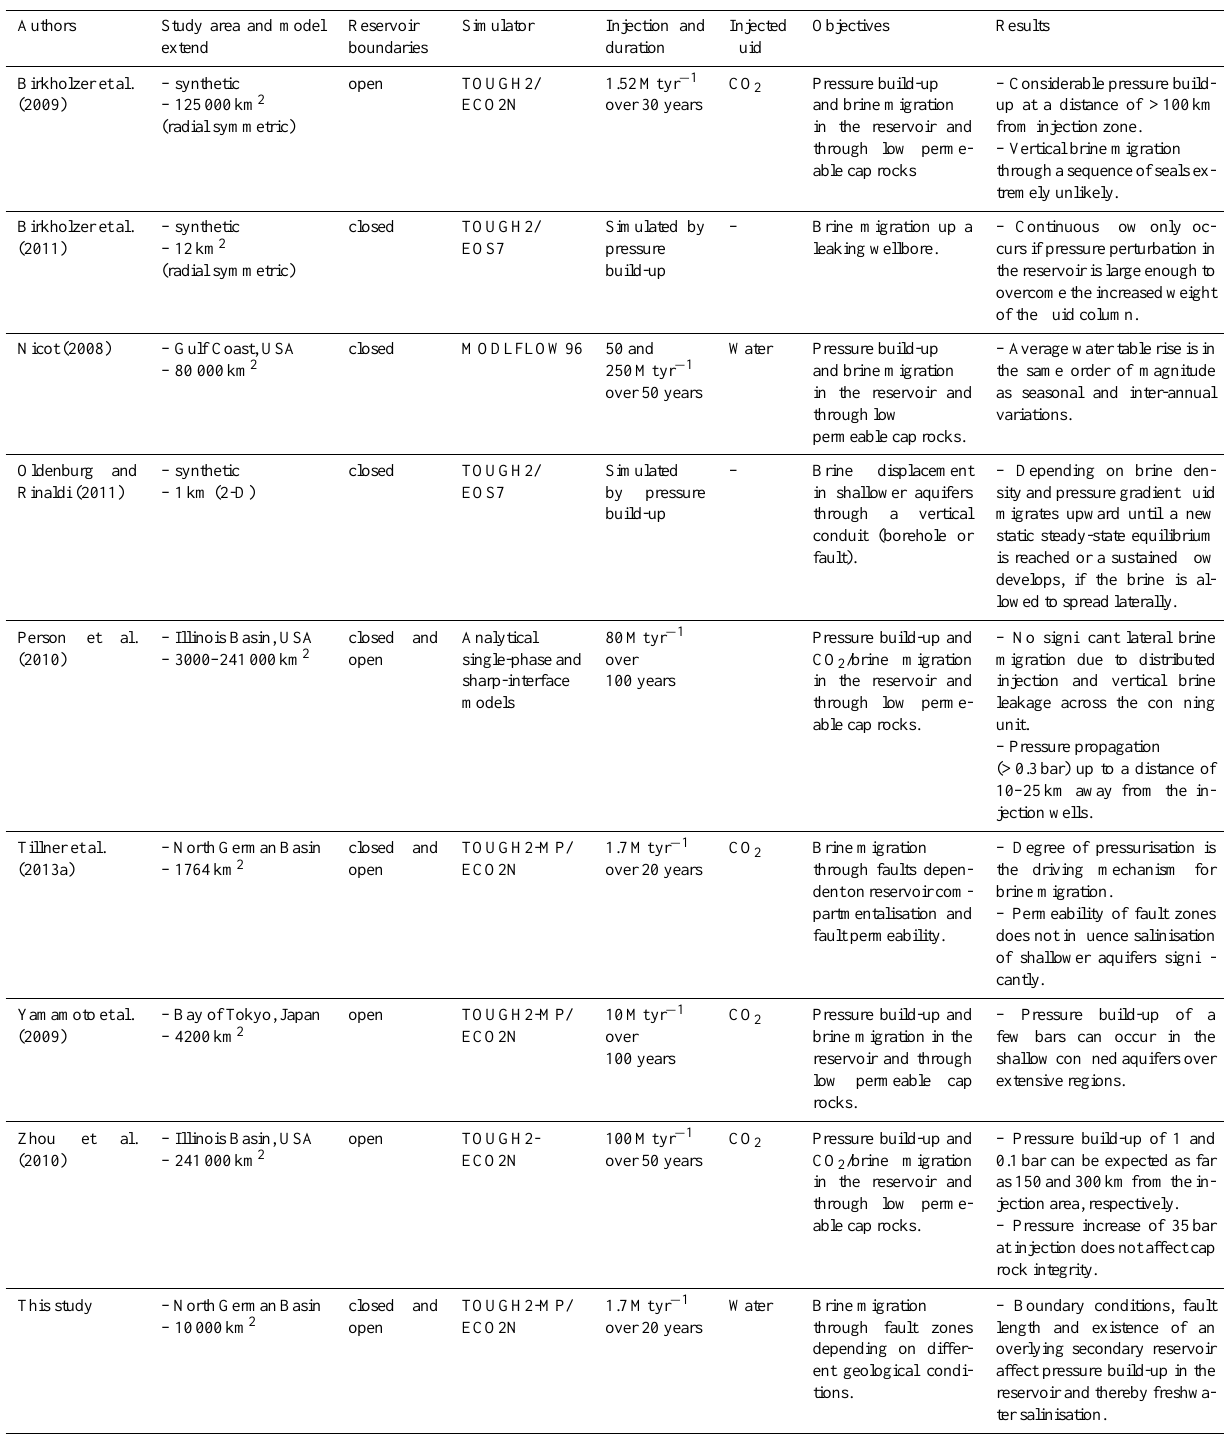
Table 1. Summary of numerical simulations of brine migration resulting from CO 2